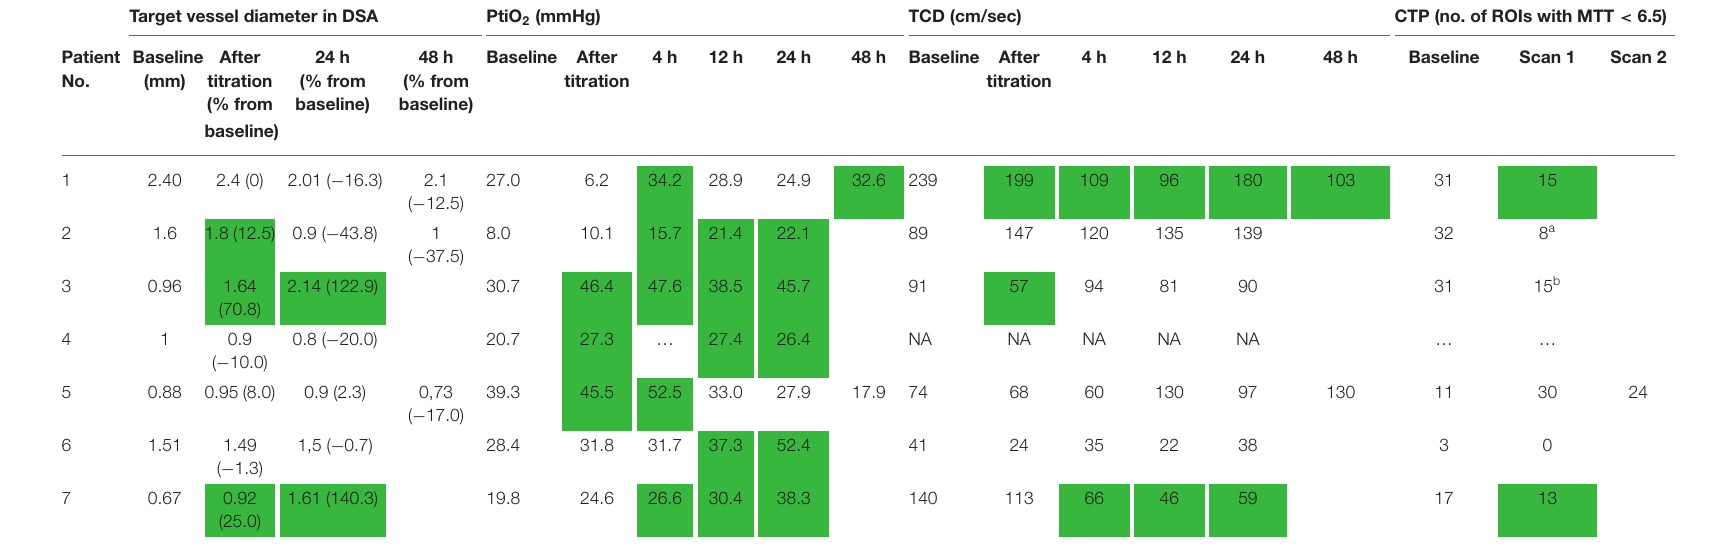
TABLE 2 | Efficacy. Target vessel diameter in DSA PtiO 2 (mmHg) TCD (cm/sec) CTP (no. of ROIs with MTT < 6.5) Patient